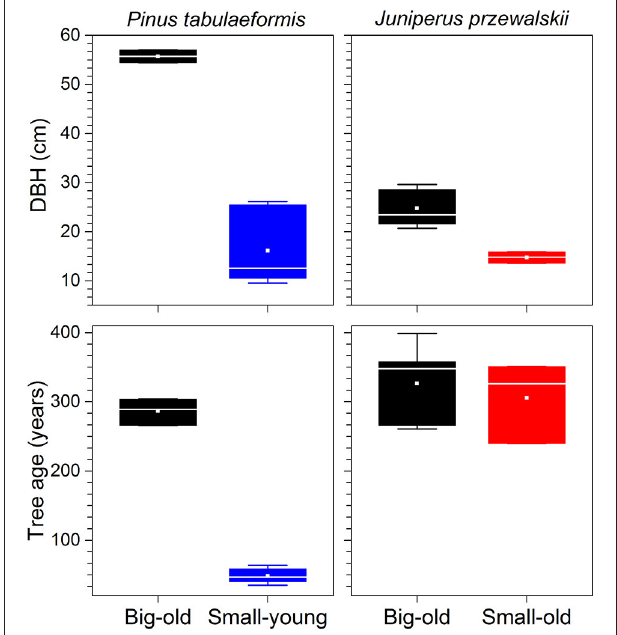
FIGURE 2 | Tree characteristics of each species investigated. Boxes represent upper and lower quartiles; whiskers achieve the 10th and 90th percentiles; the median is drawn as a horizontal white line; and the average value is shown as a white